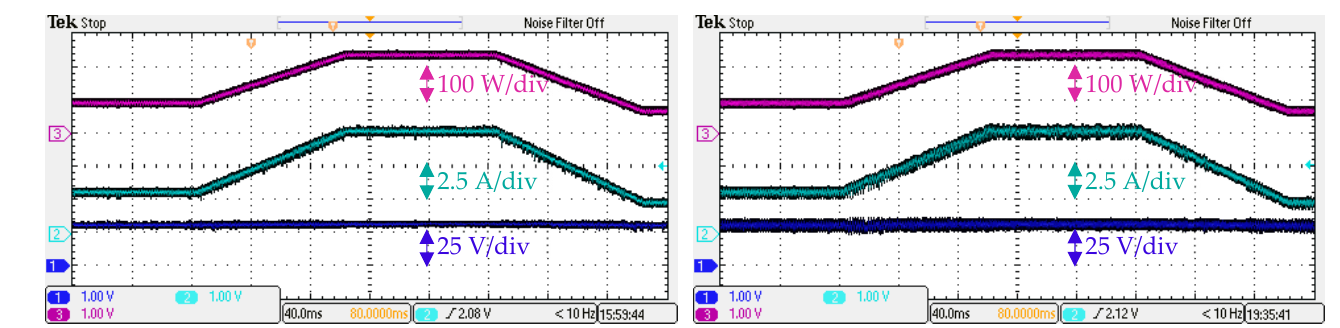
Figure 16. HIL results of power produced from panel when fast variations occurred.